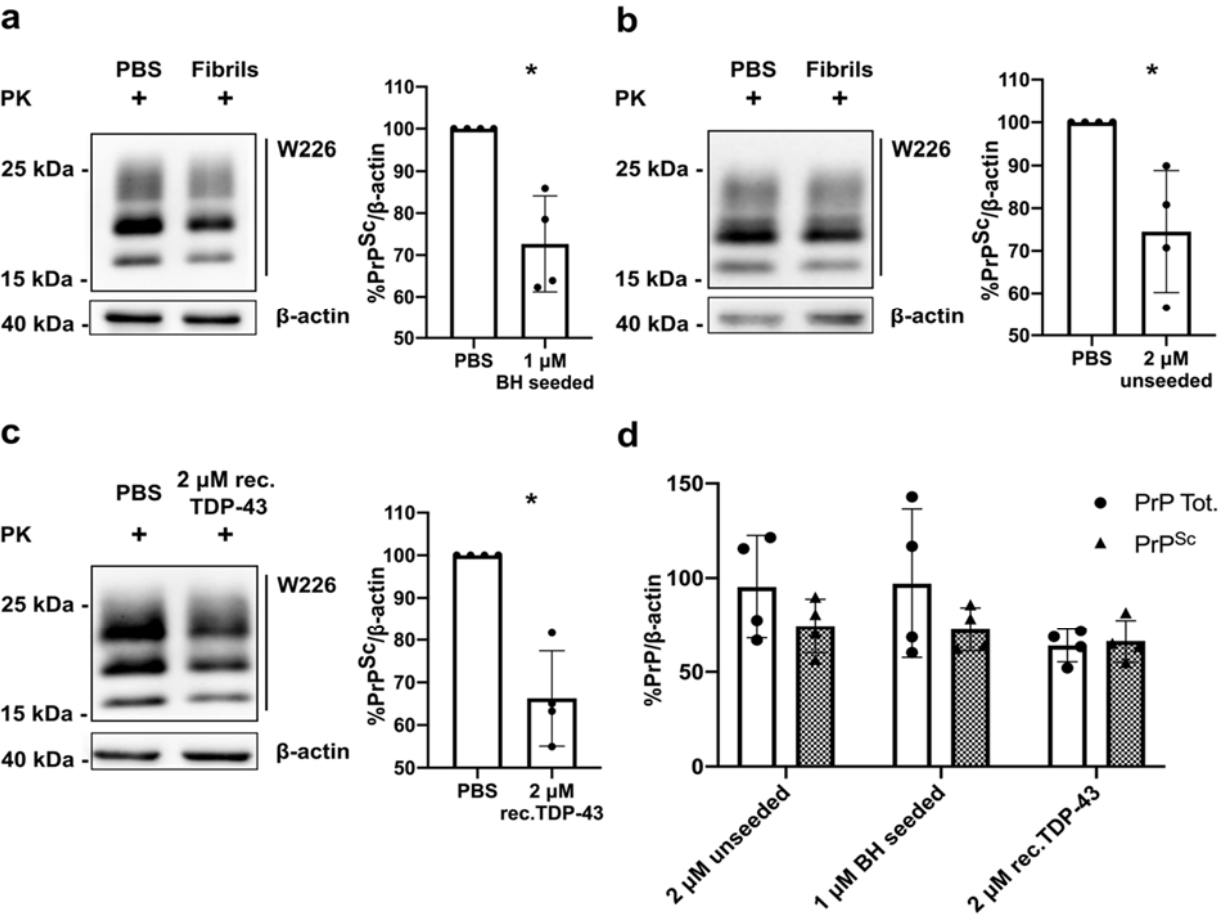
Figure 5. TDP-43-induced PrP Sc clearance in ScN2a RML cells. Representative WB analysis of PK-resistant PrP Sc and respective quantifications (graphs at the right side of each WB gel) of four independent experiments upon treatment of ScN2a RML cells with ( a ) 1 µ M BH-seeded, ( b ) 2 µ M unseeded TDP-43 LCD sonicated fibrils and ( c ) 2 µ M recombinant monomeric TDP-43 LCD. Values are shown as percentage of the PK-resistant form PrP Sc relative to β -actin, used as a loading control. Data were evaluated with Mann-Whitney test; * p < 0.05; data in the graph are reported as mean ± SD; each dot represents an independent experiment; ( d ) graphical representation of the quantification of PK-resistant and total PrP levels (i.e., the amount of PrP detected before PK treatment) for the four independent experiments upon treatment of ScN2a RML cells with 1 µ M BH-seeded, 2 µ M unseeded TDP-43 LCD sonicated fibrils and 2 µ M recombinant monomeric TDP-43 LCD. Values are shown as a percentage relative to β -actin, used as a loading control.